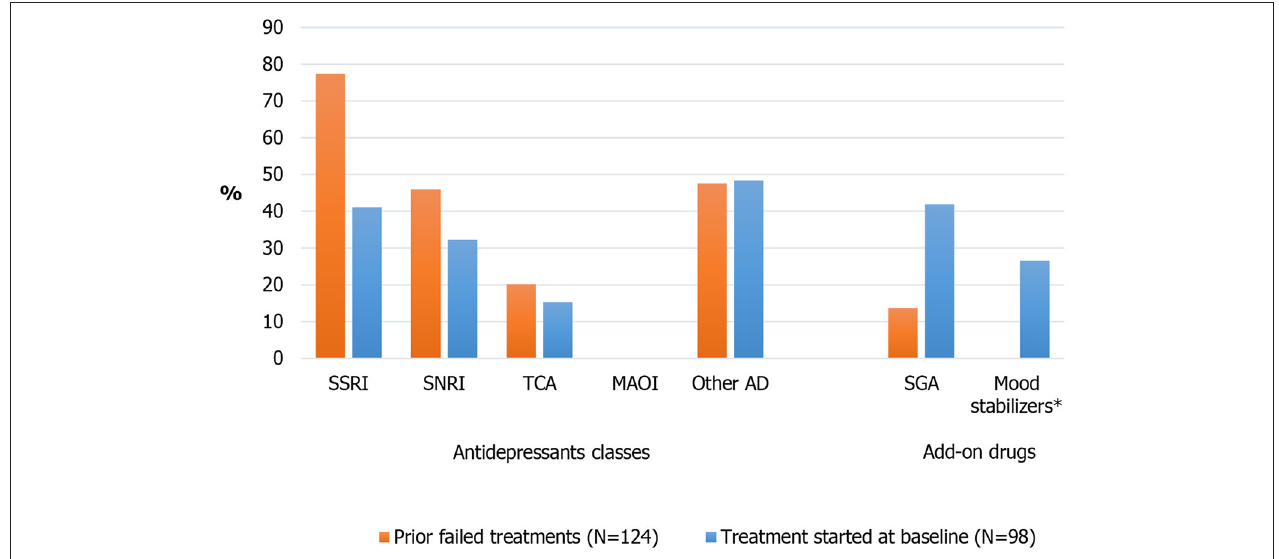
FIGURE 1 | Prior failed antidepressive treatment and treatment started at baseline. *33 patients (26.6%) were treated with add-on mood stabilizers (16 patients [12.9%] with lithium) at baseline (not documented whether treatment onging at baseline or started at baseline). AD, antidepressants; MAOI, monoamine oxidase inhibitors; SGA, second-generation antipsychotics; SNRI, serotonin-norepinephrine reuptake inhibitors; SSRI, selective serotonin reuptake inhibitors; TCA, Tricyclic antidepressants.